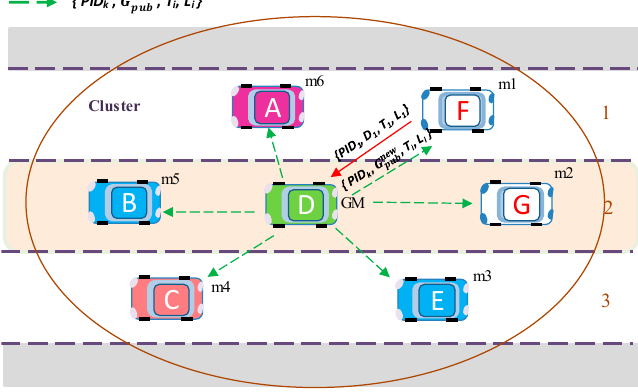
Figure 8. The GM updating a group public key G pub for group.